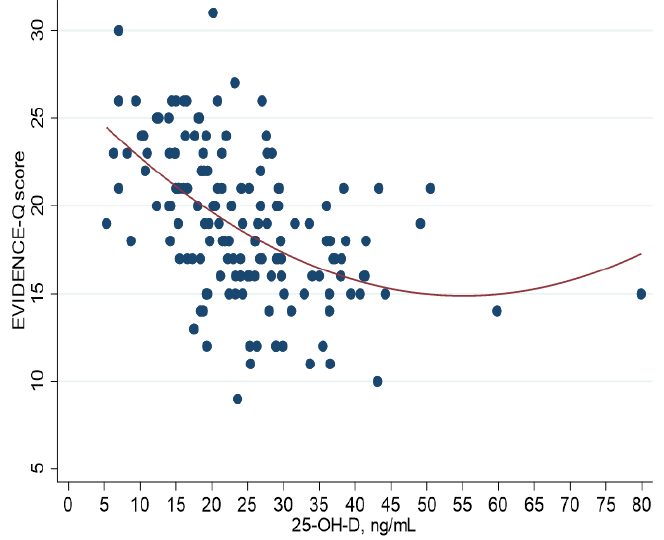
Figure 1. Scatterplot of EVIDENCE-Q score ( y -axis) versus serum 25-hydroxyvitamin D (25-OH-D) levels ( x -axis) with quadratic fitting.